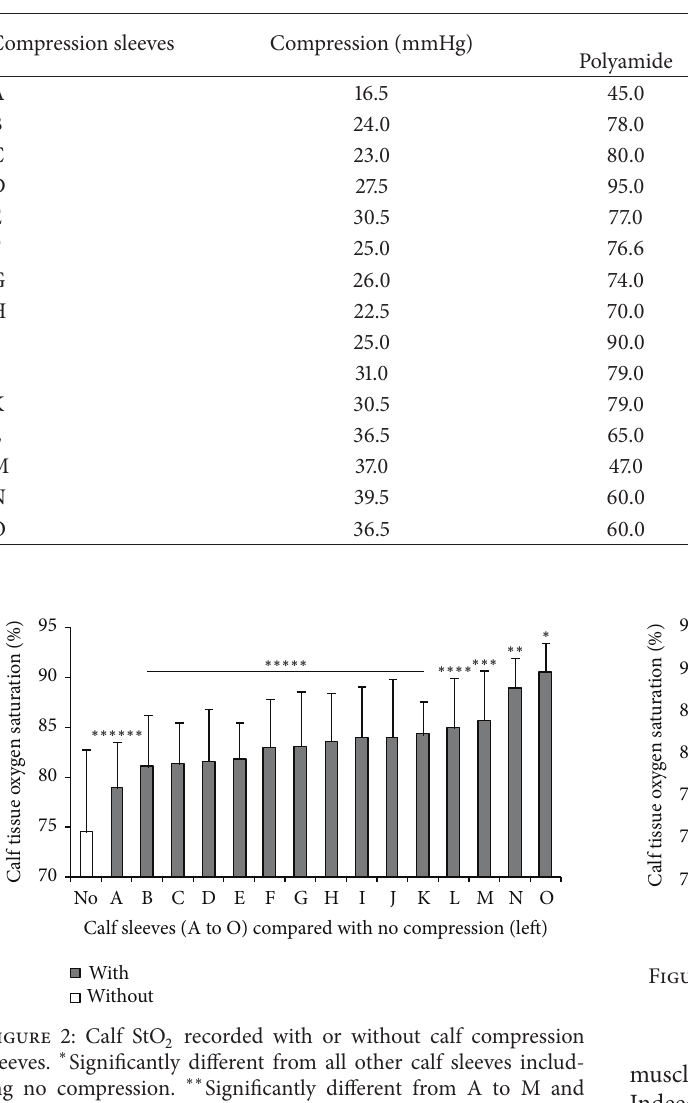
Table 1: Characteristics of calf compression sleeves.